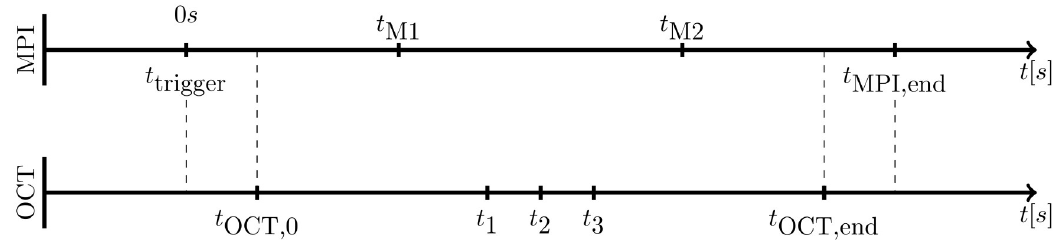
Fig 3. Time axis for synchronizing OCT device and pullback device with the help of the MPI trigger